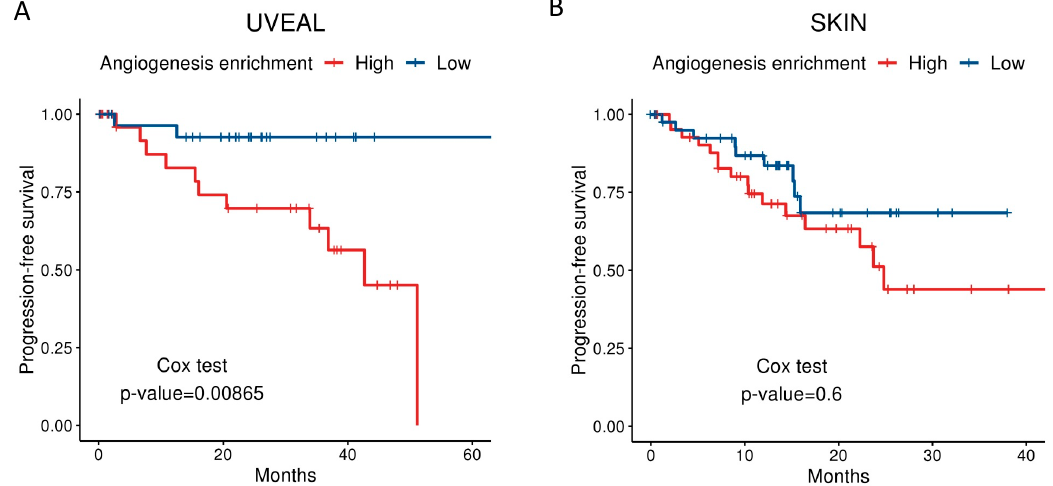
Figure 2. Disease-free survival for uveal melanoma (UM) ( A ) and cutaneous melanoma ( B ) from patients included in the TCGA, clustered into the top 50% (high angiogenesis enrichment score) vs. the bottom 50% (Low angiogenesis enrichment score). The cut-off used for generating high and low groups was the median enrichment score. The gene set used for scores was the same as for Figure 1. Data were extracted from the TCGA database through cBioPortal; 60 primary UM samples, 99 primary cutaneous melanoma samples.